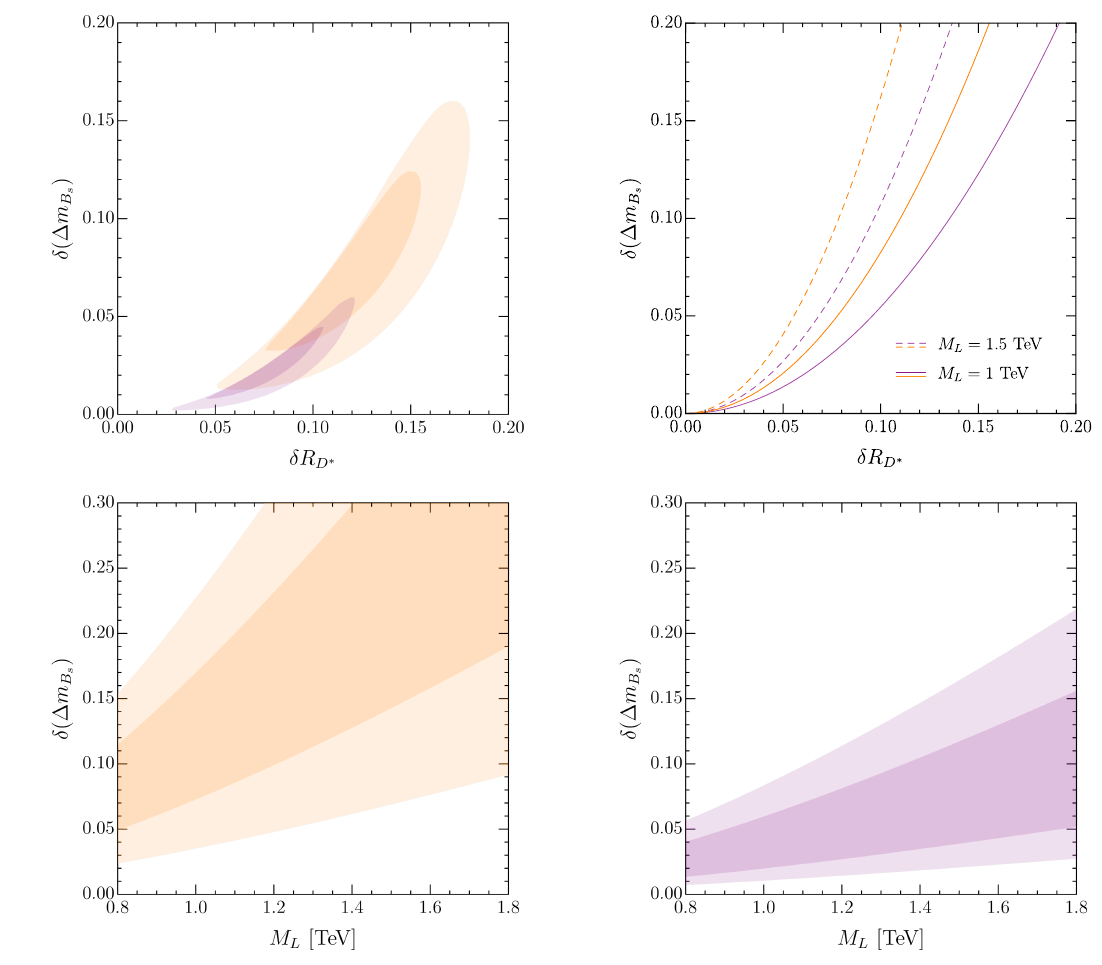
) ) plane preferred by the low- s = 1 TeV . Upper right: δ (∆ m ) as a function of δR in the UV complete bs B s D ∗ , fixing M = 4 TeV and β sτ = 0 . 15 . Lower plots: preferred 1 σ L U L ) as a function of the vector-like lepton mass for M = 4 TeV . As in the B s U = 0 and β bτ = − 1 R R